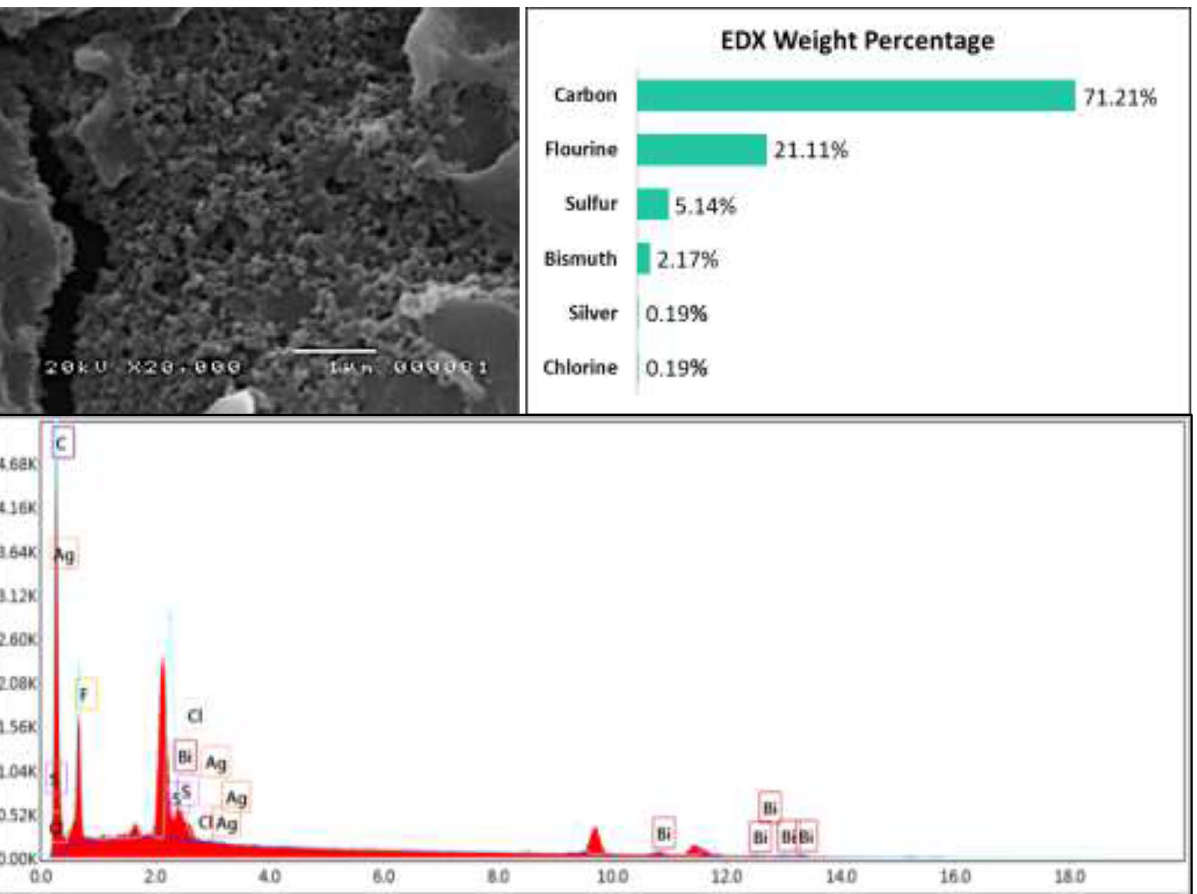
Figure 15. EDX profile of the modified